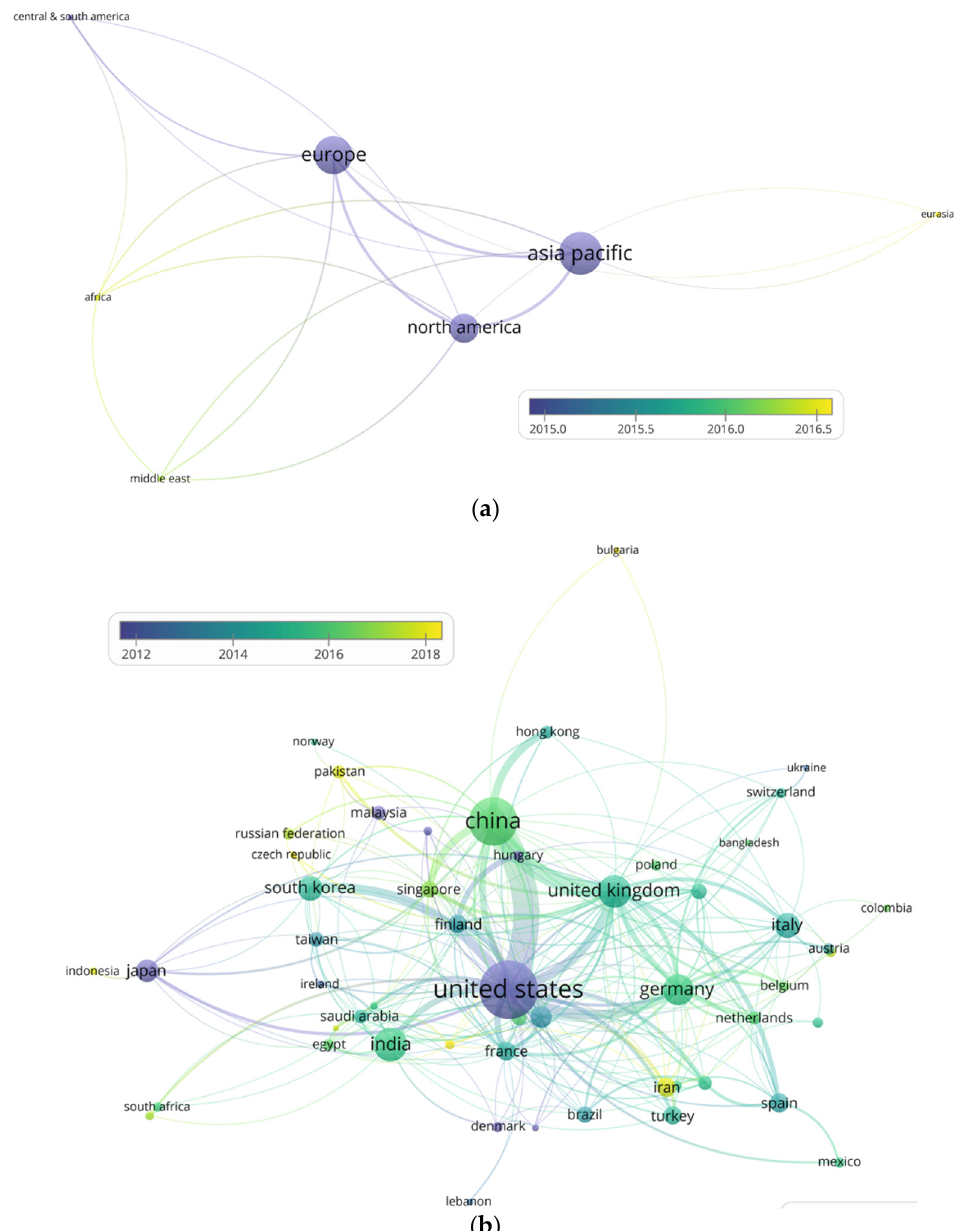
Figure 6. Countries’ relationships ( a ) considering the IEA regions ( b ) considering all countries with publications.